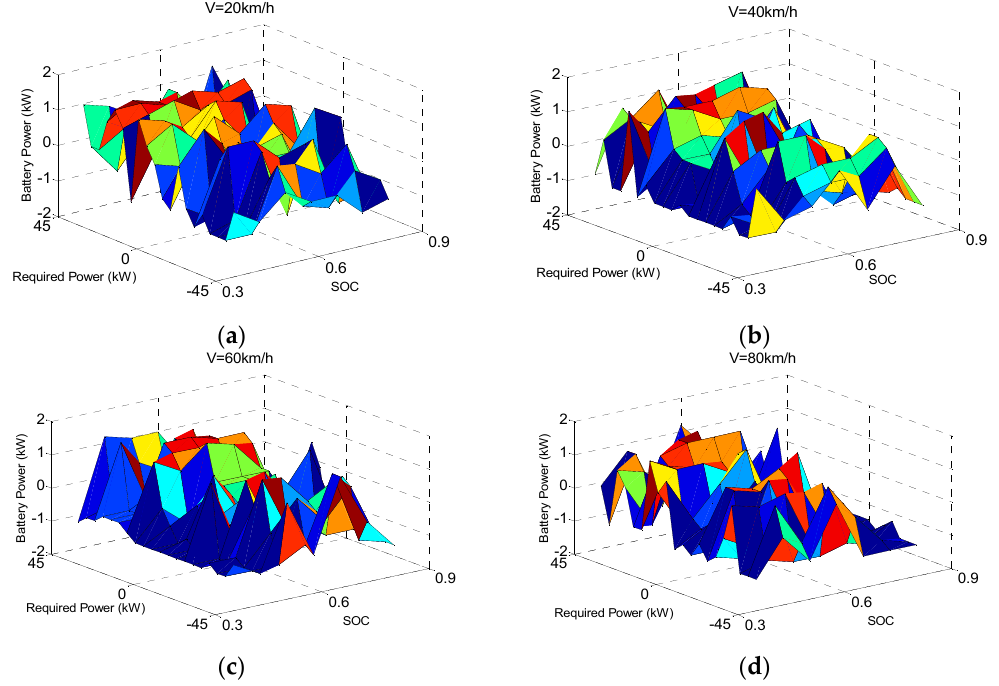
Figure 7. Optimal control strategy based on RL algorithm with different speeds. ( a ) The optimal control action variable at V = 20 km/h; ( b ) The optimal control action variable at V = 40 km/h; ( c ) The optimal control action variable at V = 60 km/h; and ( d ) The optimal control action variable at V = 80 km/h.